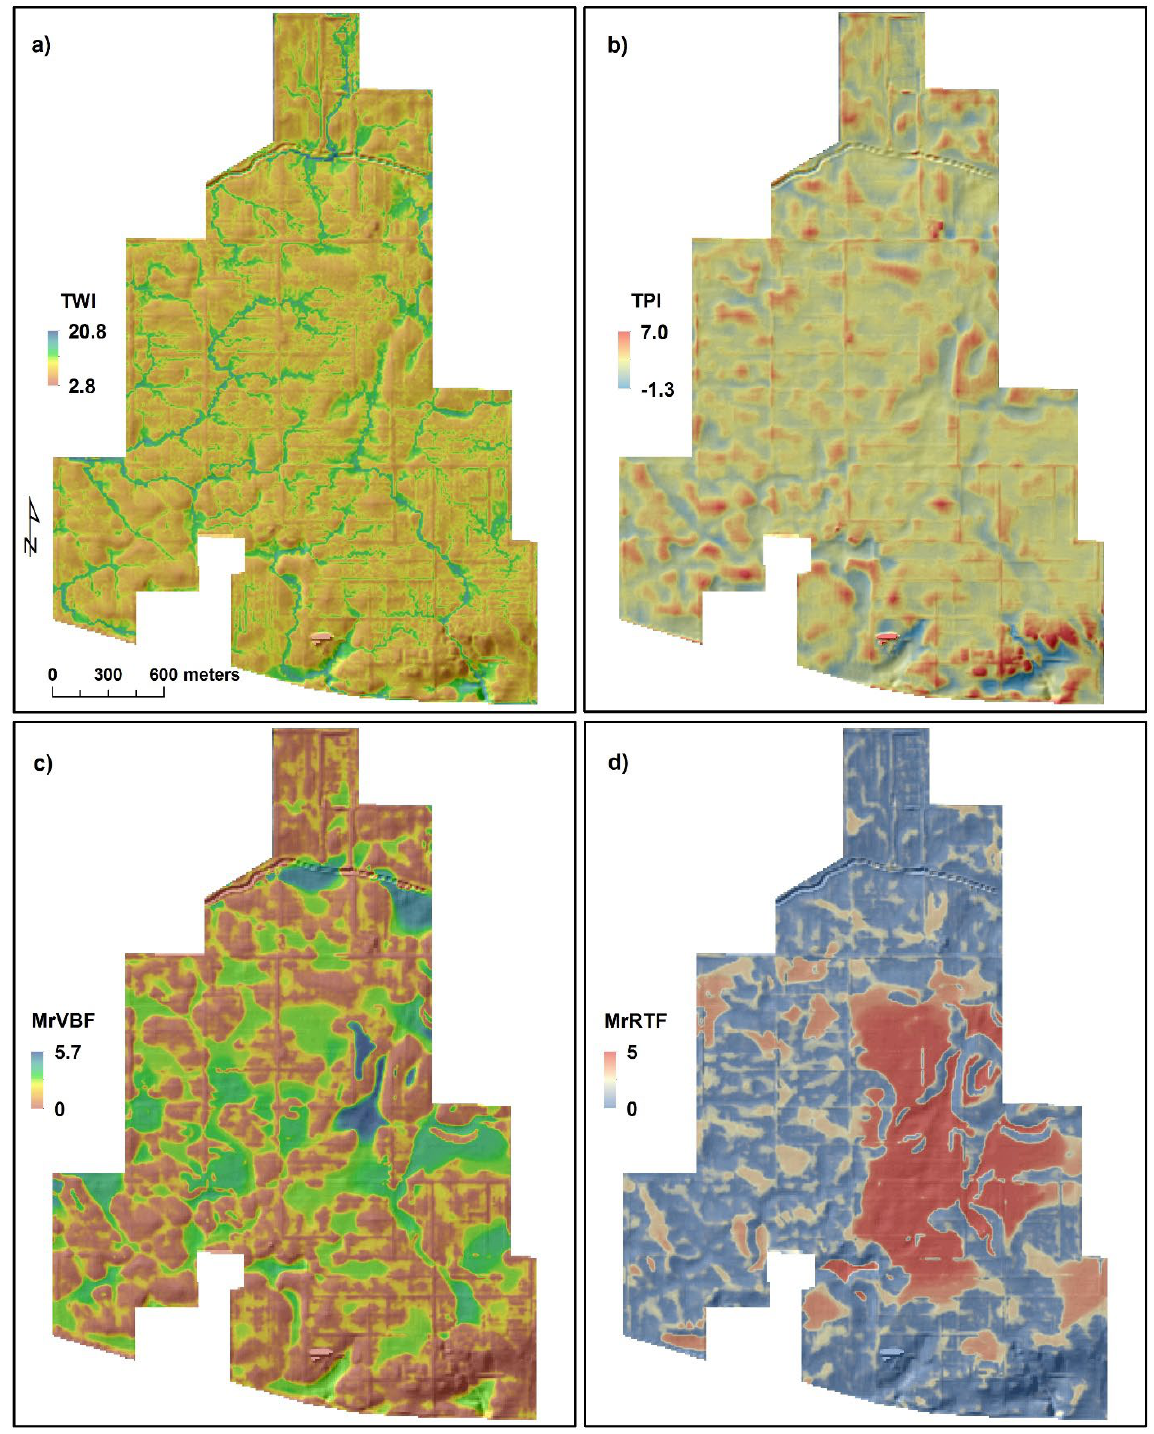
Figure 3. Terrain attributes calculated from the digital elevation model. ( a ) Topographic wetness index (TWI), ( b ) topographic position index (TPI), ( c ) multi resolution valley bottom flatness index (MrVBF), and ( d ) multi resolution ridge top flatness index (MrRTF). Topographic Wetness